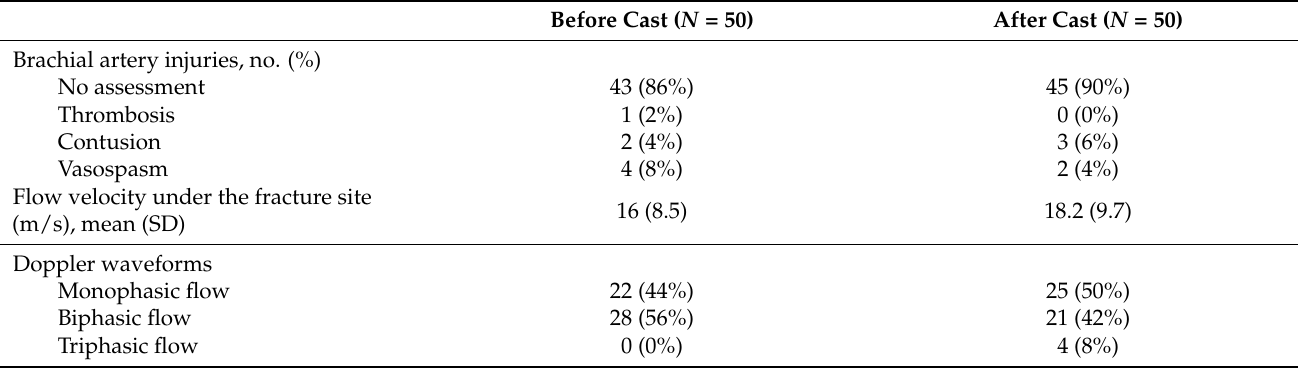
Table 3. Frequency of treatment methods with age group and length of lesions on multislice CT-A.